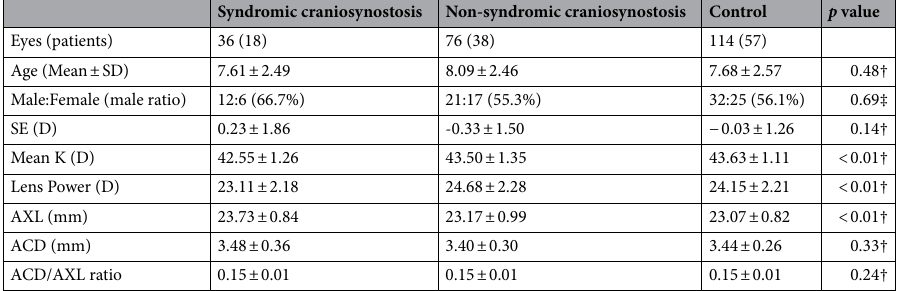
Table 2. Biometric characteristics of syndromic, non-syndromic craniosynostosis and control group. ACD, anterior chamber depth; AXL, axial length; K, keratometry; SD, standard deviation; SE, spherical equivalent; †, one-way ANOVA test; ‡, Fisher’s exact test.